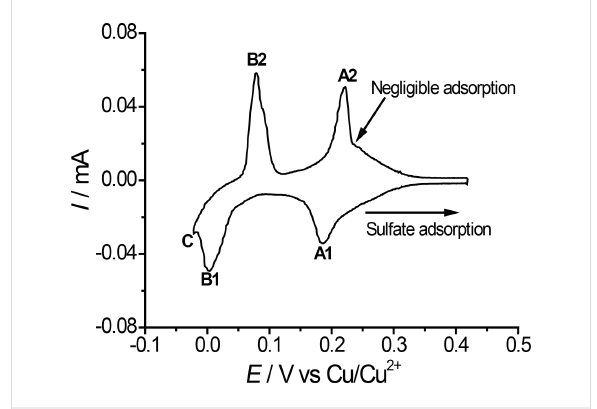
Figure 1: Cyclic voltammogram in 0.05 M H 2 SO 4 + 4 × 10 − 4 M CuSO 4 . v = 50 mV/s.